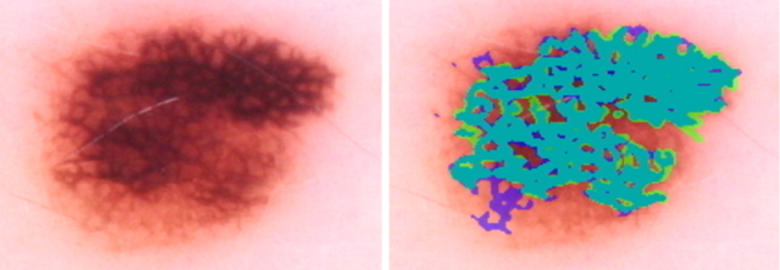
Figure 5. IoU = 0.78; DL can detect the areas of darkened lines and constricted holes in this melanoma.